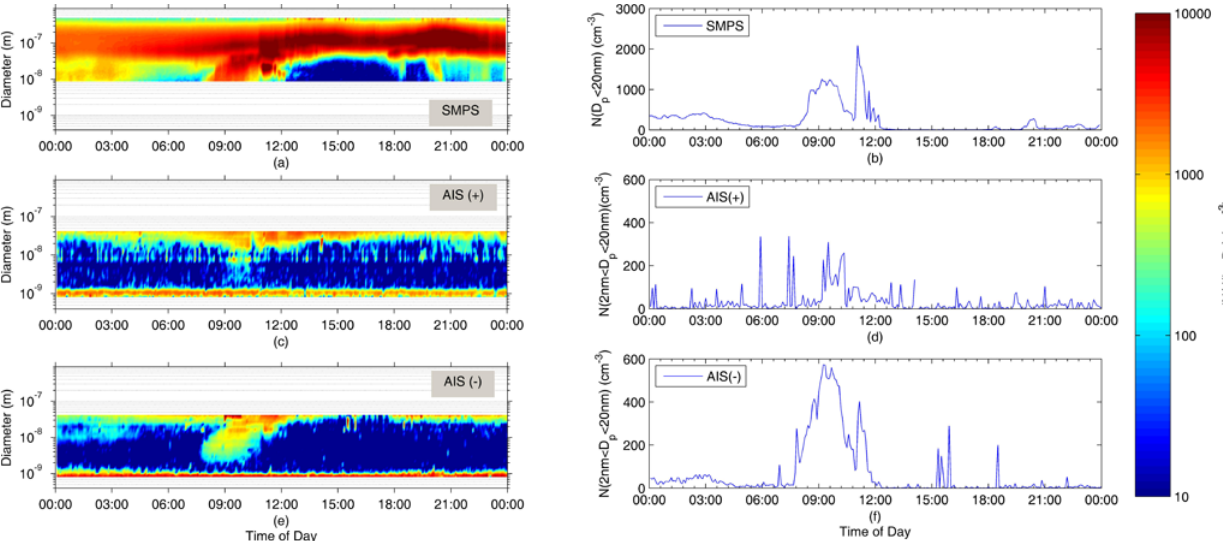
Fig. 4. New particle formation event recorded at Finokalia on 16 June 2008. Time evolution of aerosol particles size distribution in the size range 8–900nm (a) and number concentration for diameters smaller than 20nm as recorded by the SMPS (b) , atmospheric ions size distribution in the size range 0.8–42nm and number concentration for diameters between 2 and 20nm for positive (c, d) and negative (e, f) ions measured with the AIS. Time of the day in